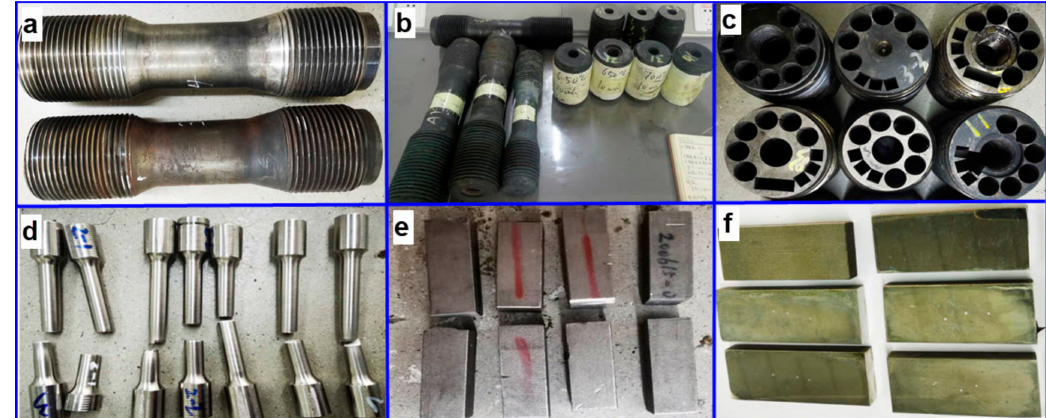
Figure 1. Experimental procedure and sample collection method: ( a ) original bolts sample, ( b ) bolts after aging process, ( c ) bolts after sampling process, ( d ) samples after tensile test, ( e ) samples after impact test, ( f ) samples for microstructural test.